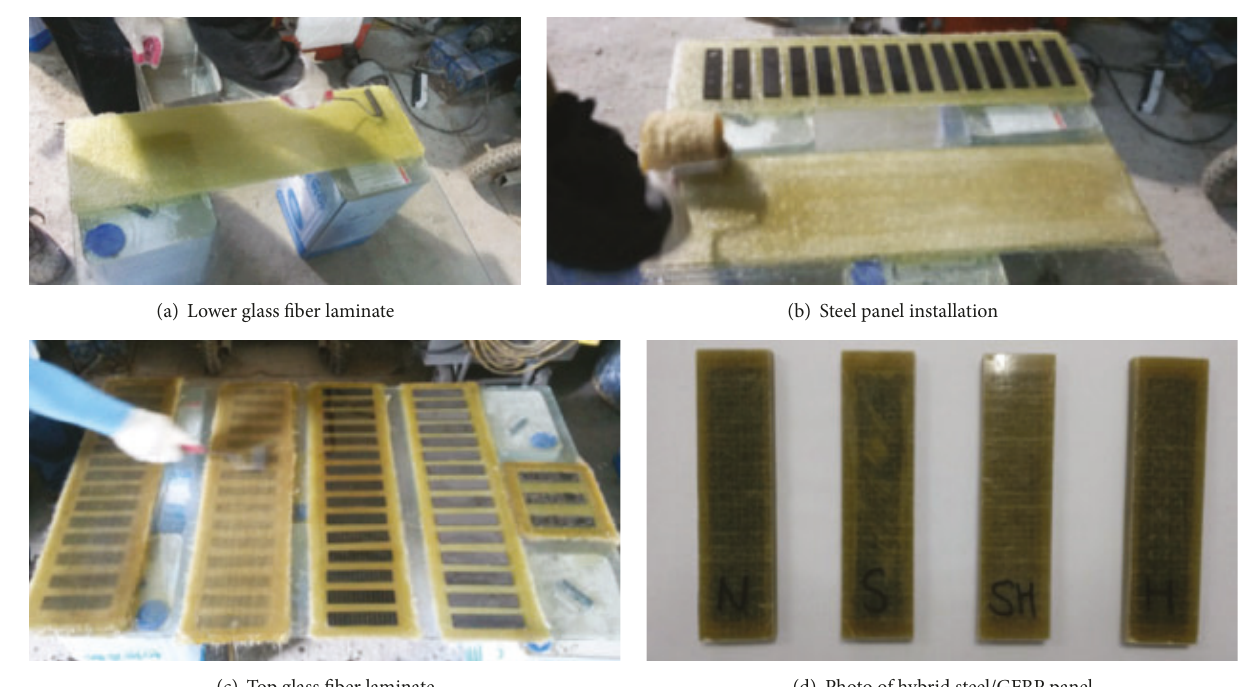
Figure 4: Manufacturing process of hybrid panels.